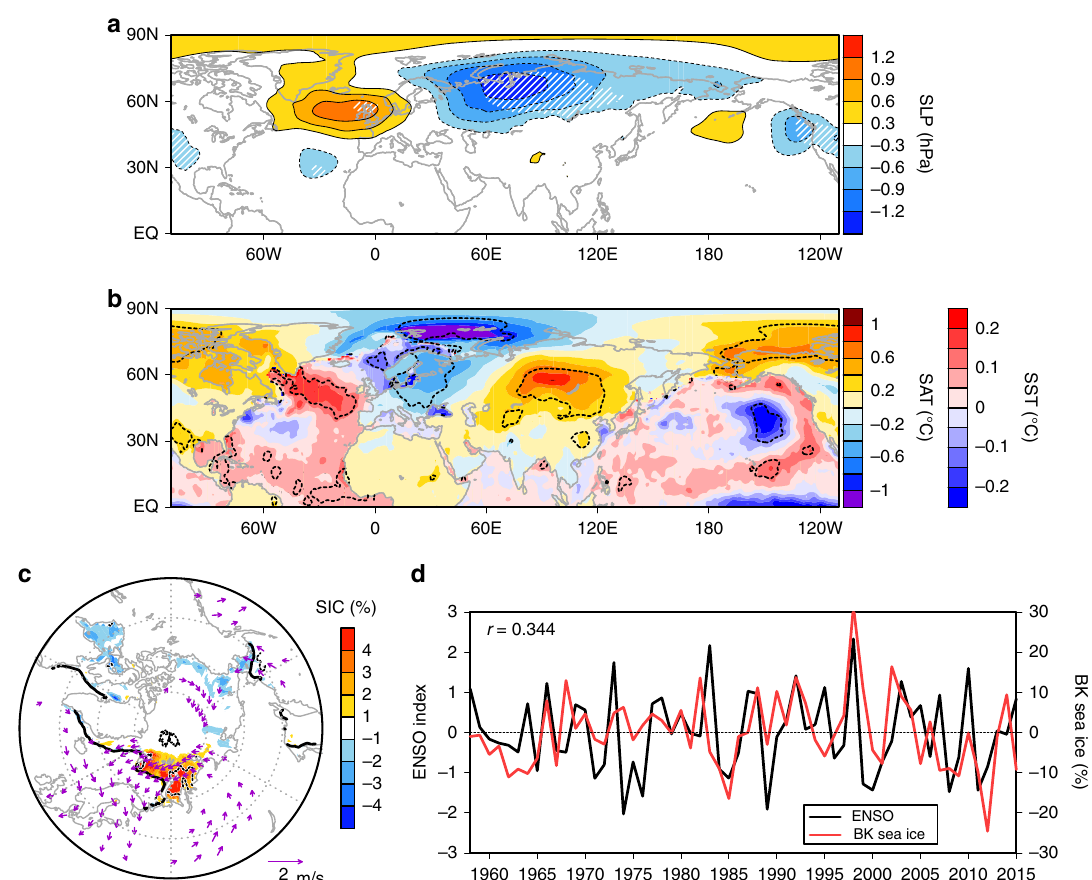
Fig. 1 Observed climate anomalies in early winter of El Niño-decay year. Regressed anomalies of a sea level pressure (SLP), b surface air temperature (SAT) and sea surface temperature (SST) and c sea ice concentration (SIC) (shading) and 925-hPa wind velocity (vectors; limited to 50° – 82°N) in early winter onto the El Niño – Southern Oscillation (ENSO) index in preceding winter (ENSO( – 1)). SAT is shown over land or ice while SST is shown over open ocean in b . Hatching in a and black-dotted contours in b , c indicate statistical signi fi cance (for SIC in c ) at the p <0.05 level, and thick black contours in c indicate mean SIC of 10%. d Time series of the detrended ENSO index (1-year forward shift) and SIC anomalies averaged in the Barents – Kara (BK) Seas (70° – 80°N, 50° –